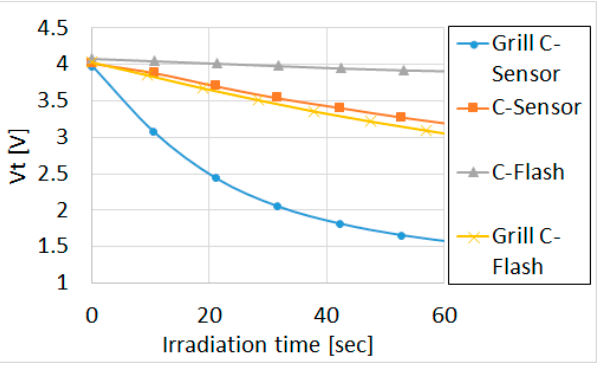
Figure 7. Different FG sensors discharge rate by 255 nm UV, with intensity of ~500 µW/cm².